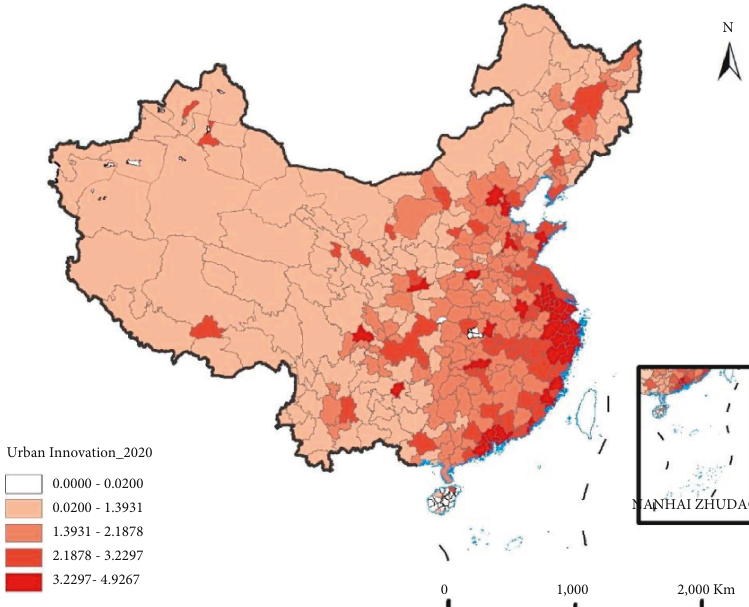
Figure 3: Spatial distribution map of China’s urban innovation in